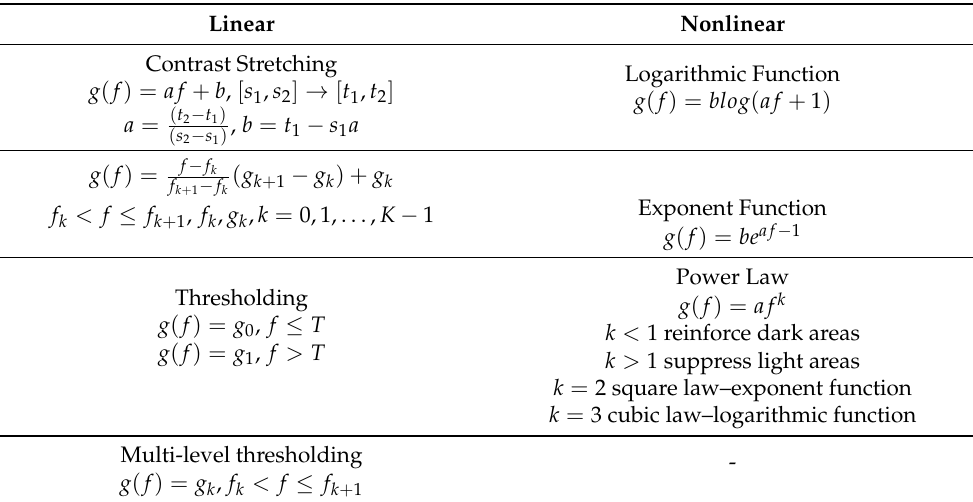
Table 1. Linear and nonlinear histogram modification techniques where 0 = f min < g < f max = L − 1 . Linear Nonlinear Contrast